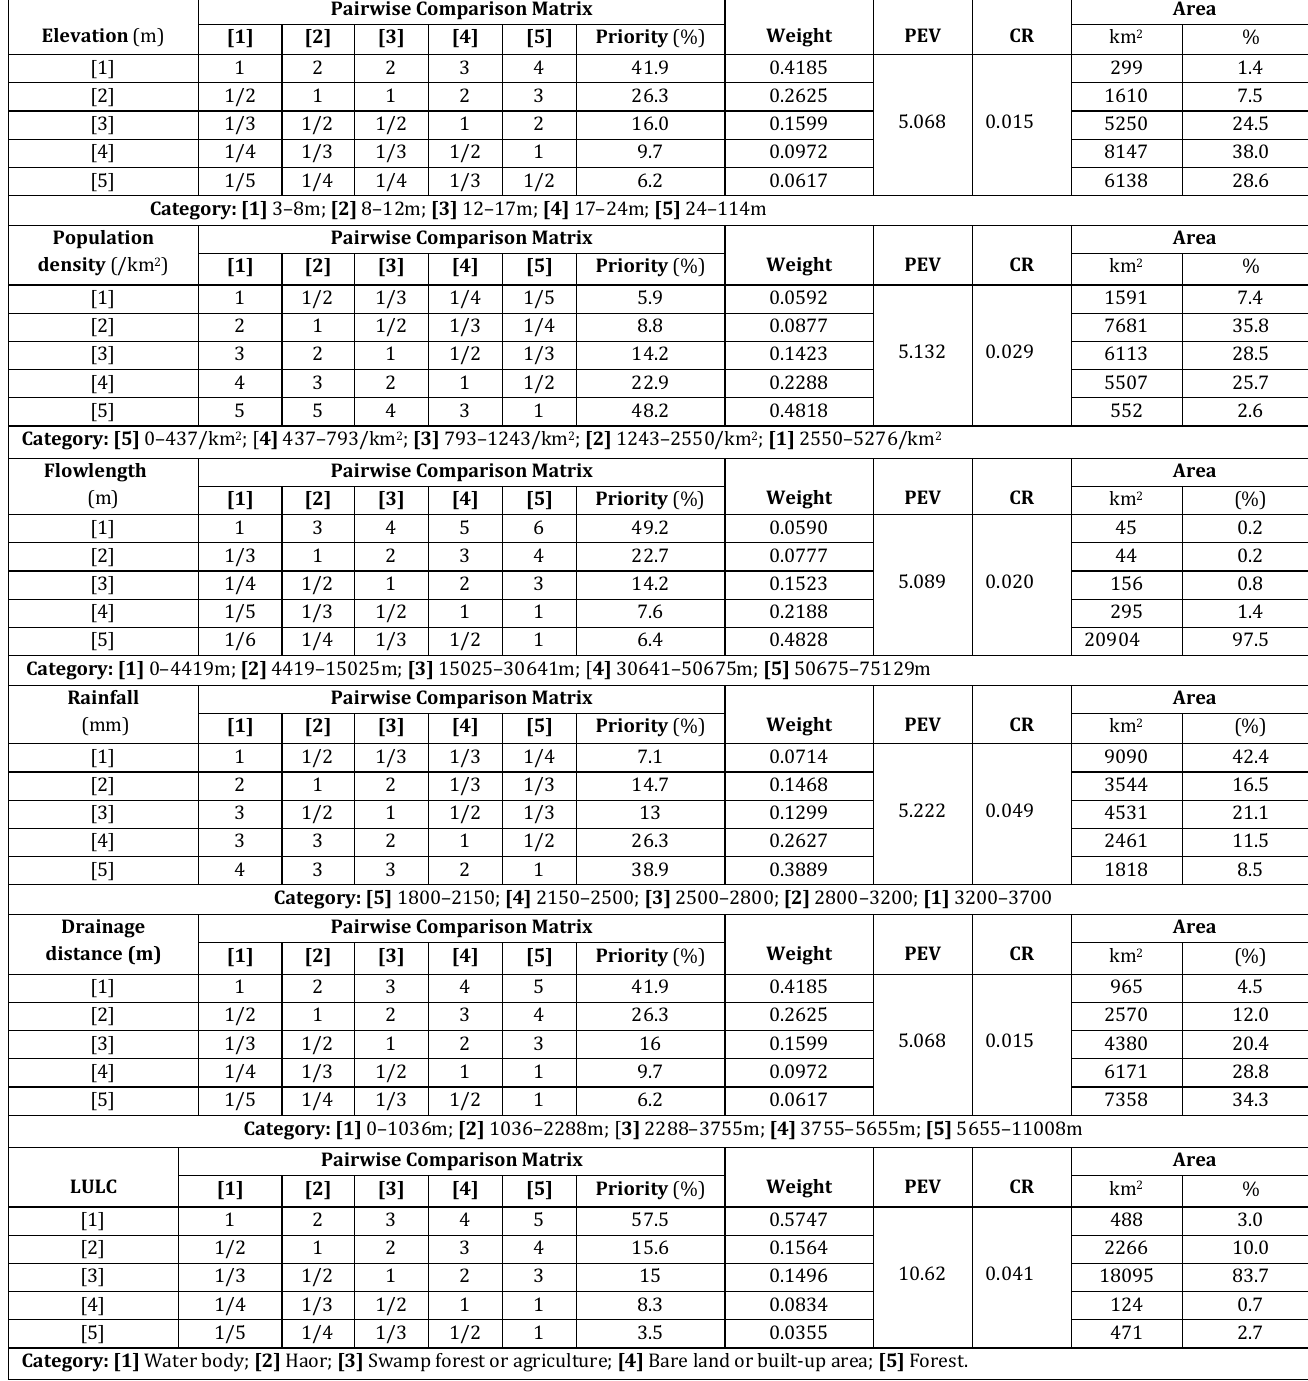
Table 3: AHP values for individual parameters. The numbers in the left-hand column are category numbers. Category 1 corresponds to 'very high susceptibility', Category 5 to 'very low susceptibility'. The relevant range of the parameter (type for LULC) for each category is given at the end of each section in the table. Priority: numbers associated with the nodes of an AHP hierarchy; PEV: principal eigenvalue; CR: consistency ratio.